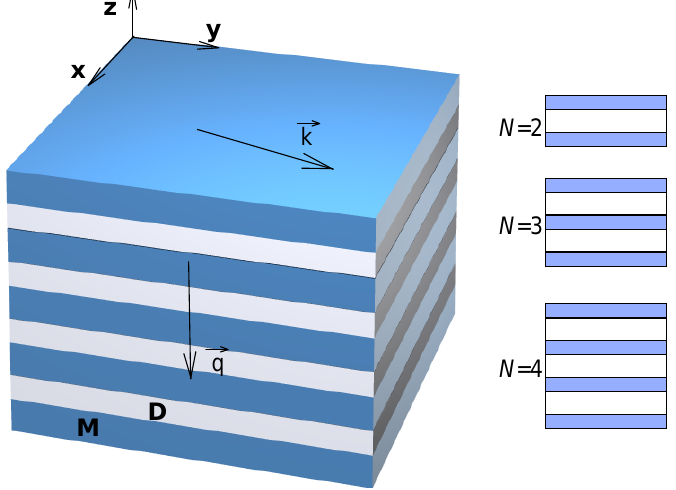
2. Geometry of the 1D subwavelength plasmonic crystal.